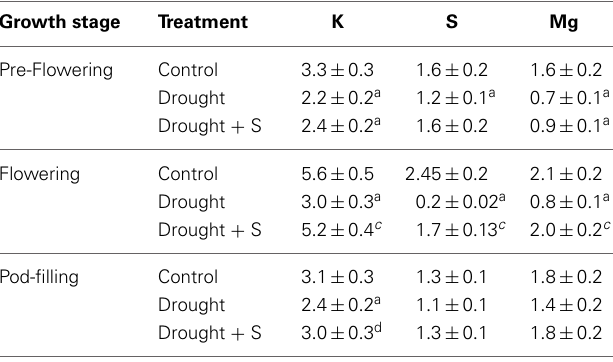
Table 4 | Potassium (K), sulfur (S), and magnesium (Mg) contents ( µ mol g − 1 dry weight) in mungbean ( Vigna radiata ) leaves